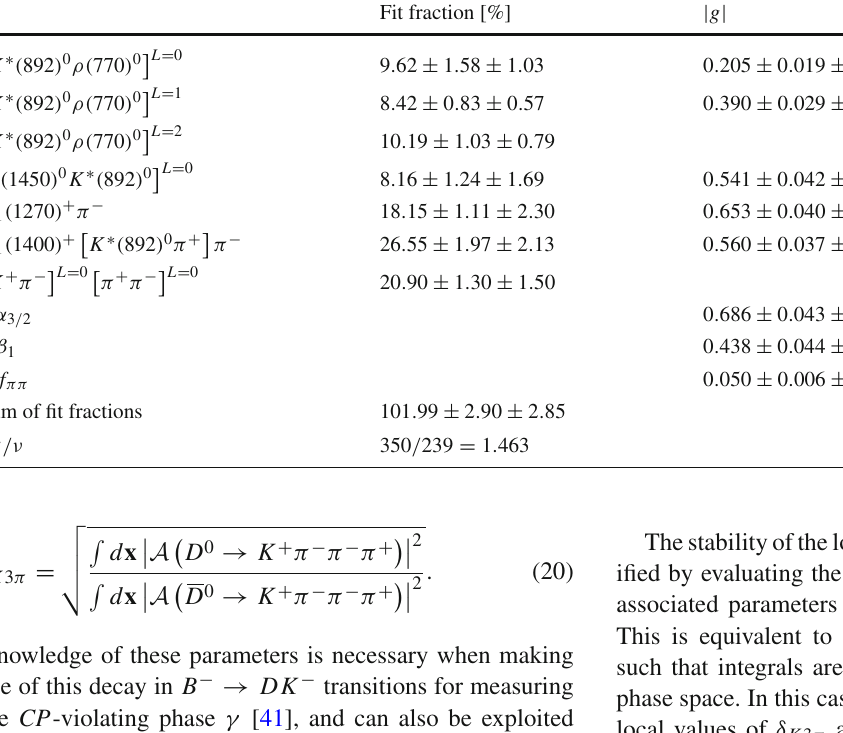
Table 6 Fit fractions and coupling parameters for the WS decay the coupling to the decay D 0 → [ K ∗ ( 892 ) 0 ρ( 770 ) 0 ] L = 2 . Also given D 0 → K + π − π − π + . For each parameter, the first uncertainty is statis- are the χ 2 and the number of degrees of freedom ( ν ) from the fit and tical and the second systematic. Couplings g are defined with respect to their ratio Fit fraction [%] | g | arg ( g ) [ ◦